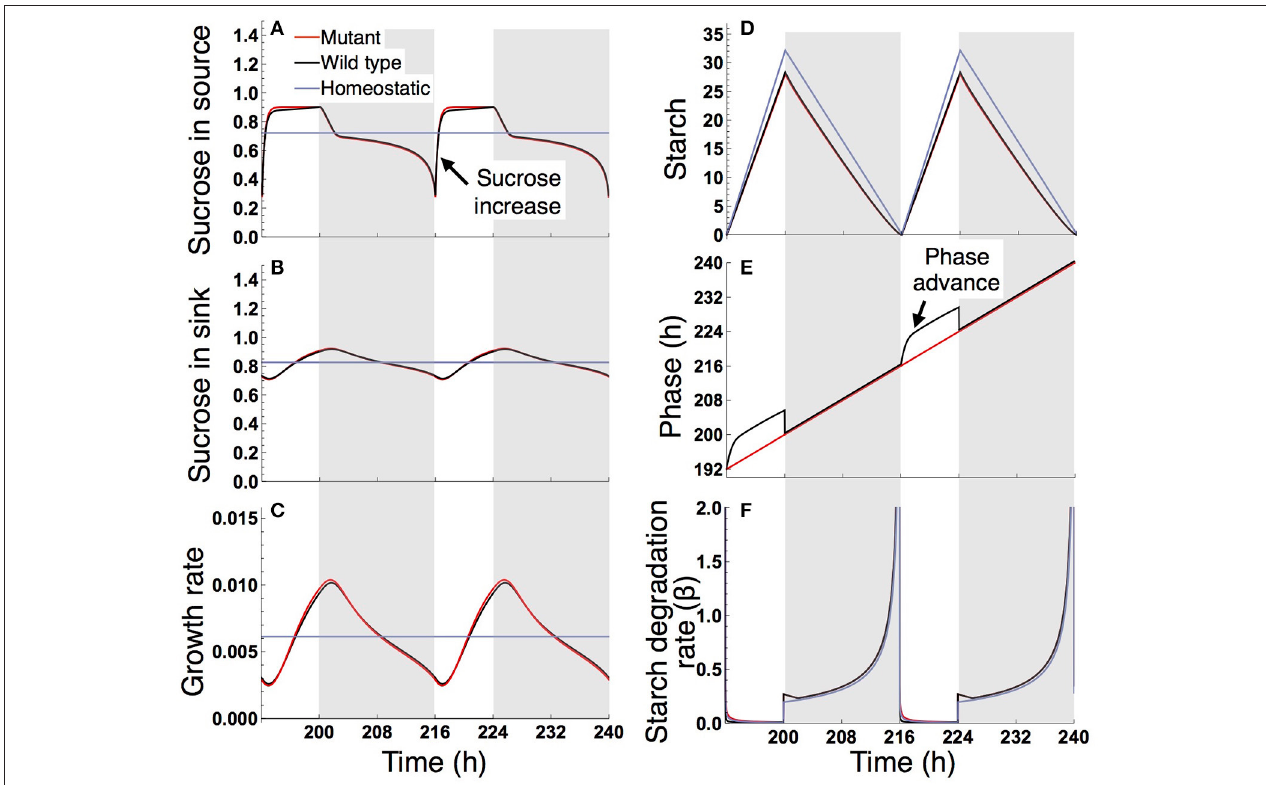
FIGURE 5 | Predicted profiles of (A) sucrose in the source, (B) sucrose in the sink (SAM or RAM), (C) growth rate of the sink (SAM or RAM), (D) starch, (E) phase, and (F) starch degradation rate of the plants grown in an 8-h photoperiod. Details are as in the legend to Figure 4 .